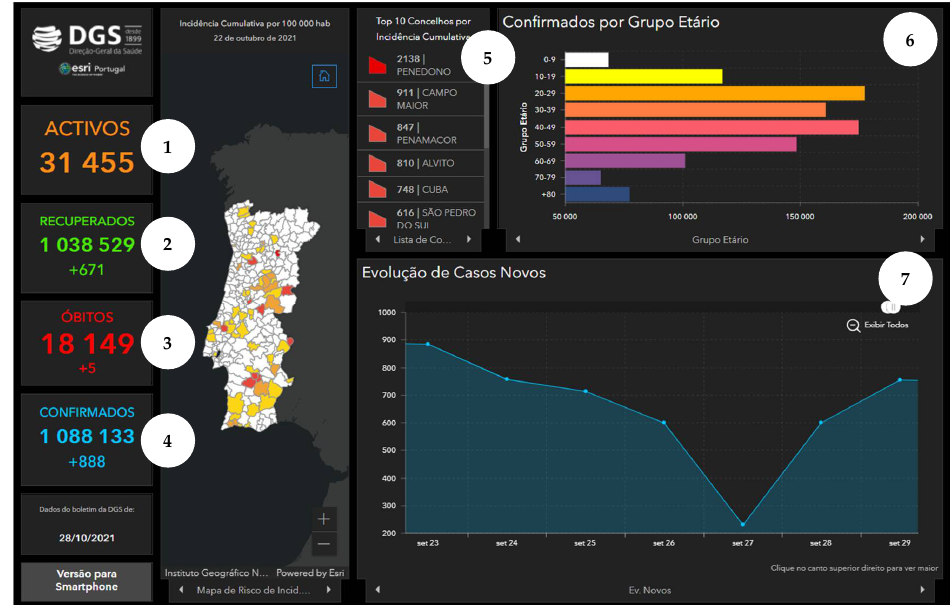
Figure 3. Screen of the DGS COVID-19 Dashboard available at https://covid19estamoson.gov.pt/estado-epidemiologico-covid19-portugal/, accessed on 28 October 2021. Note: The figure content is written in Portuguese. First column of the screen shows COVID-19 statistics: 1—Number of Active Cases (total), 2—Number of Recovered (total and daily), 3—Number of Deaths (total and daily), 4—Number of Confirmed Cases (total and daily); second column presents a map of Portugal with Cumulative incidence per 100,000 hab. by Municipality, on 22 October 2021; third and fourth columns show (from left to right, top to bottom): 5—List with Names and Cumulative Incidence of Top 10 Municipalities with higher incidence, 6—Number of Cases ( x -axis) per Age Group ( y -axis), 7—Evolution of New Cases ( y -axis) between 23 and 29 September 2021 ( x -axis) (screen from